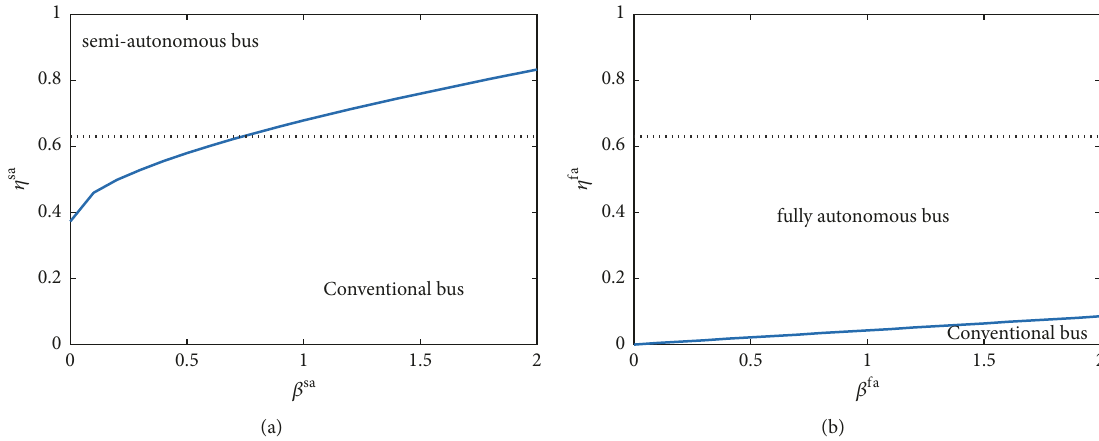
Figure 4: Applicability of (a) semi-autonomous buses and (b) fully autonomous buses, as functions of additional fixed unit capital and reduced operating costs 𝛽 sa , 𝜂 sa , 𝛽 fa , 𝜂 fa . The horizontal dashed line indicates the upper bound 0.63. Other parameters according to Table 2.